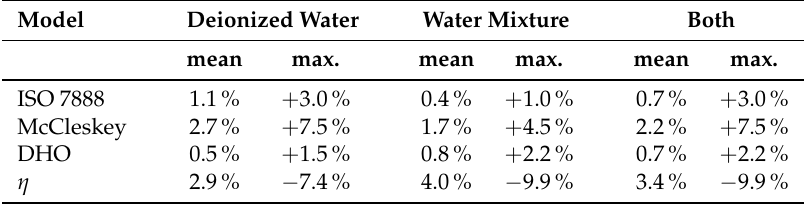
Table 2. Mean and maximum relative deviation of compensated cross-sectional sensor average Model Deionized Water Water Mixture Both mean max. mean max. mean max. ISO